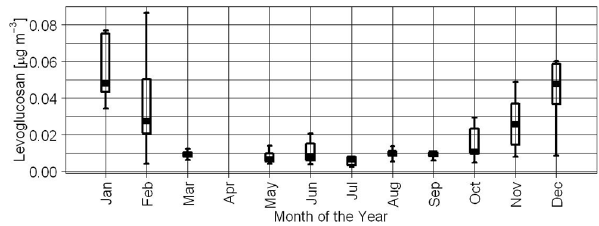
Fig. 1. Monthly variation of levoglucosan concentrations measured at EROS between 23 June 2008 and 31 March 2010. the values of C 2 changed little, but C 3 was 0.619 µg m − 3 in winter and 2.74 µg m − 3 in summer.